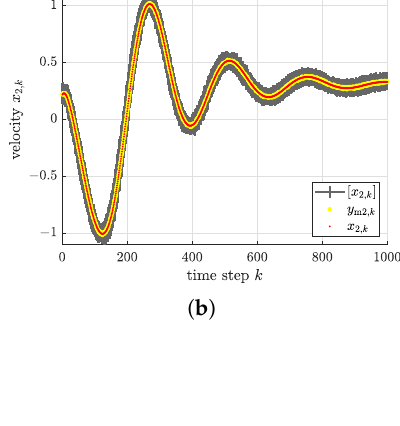
(cid:2) (cid:3) d 3, k vs. true